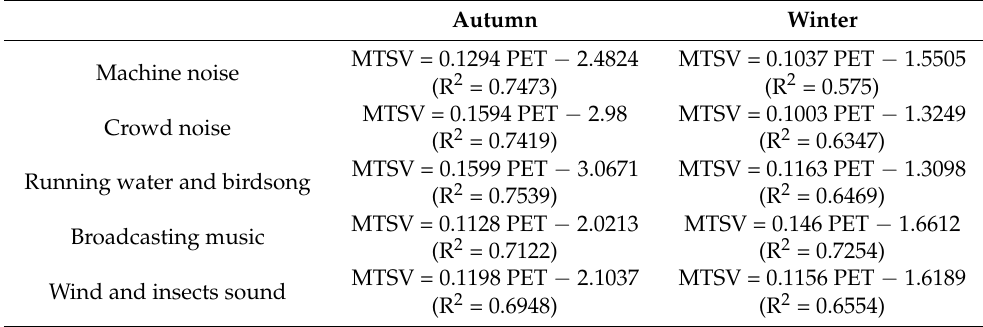
Table 5. Correlation between PET and MTSV in different sound types.